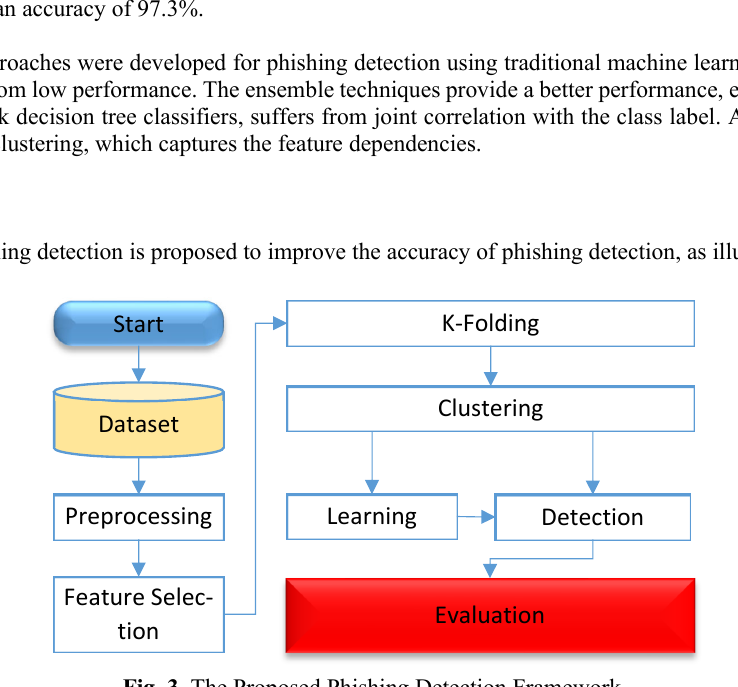
Fig. 3. The Proposed Phishing Detection Framework